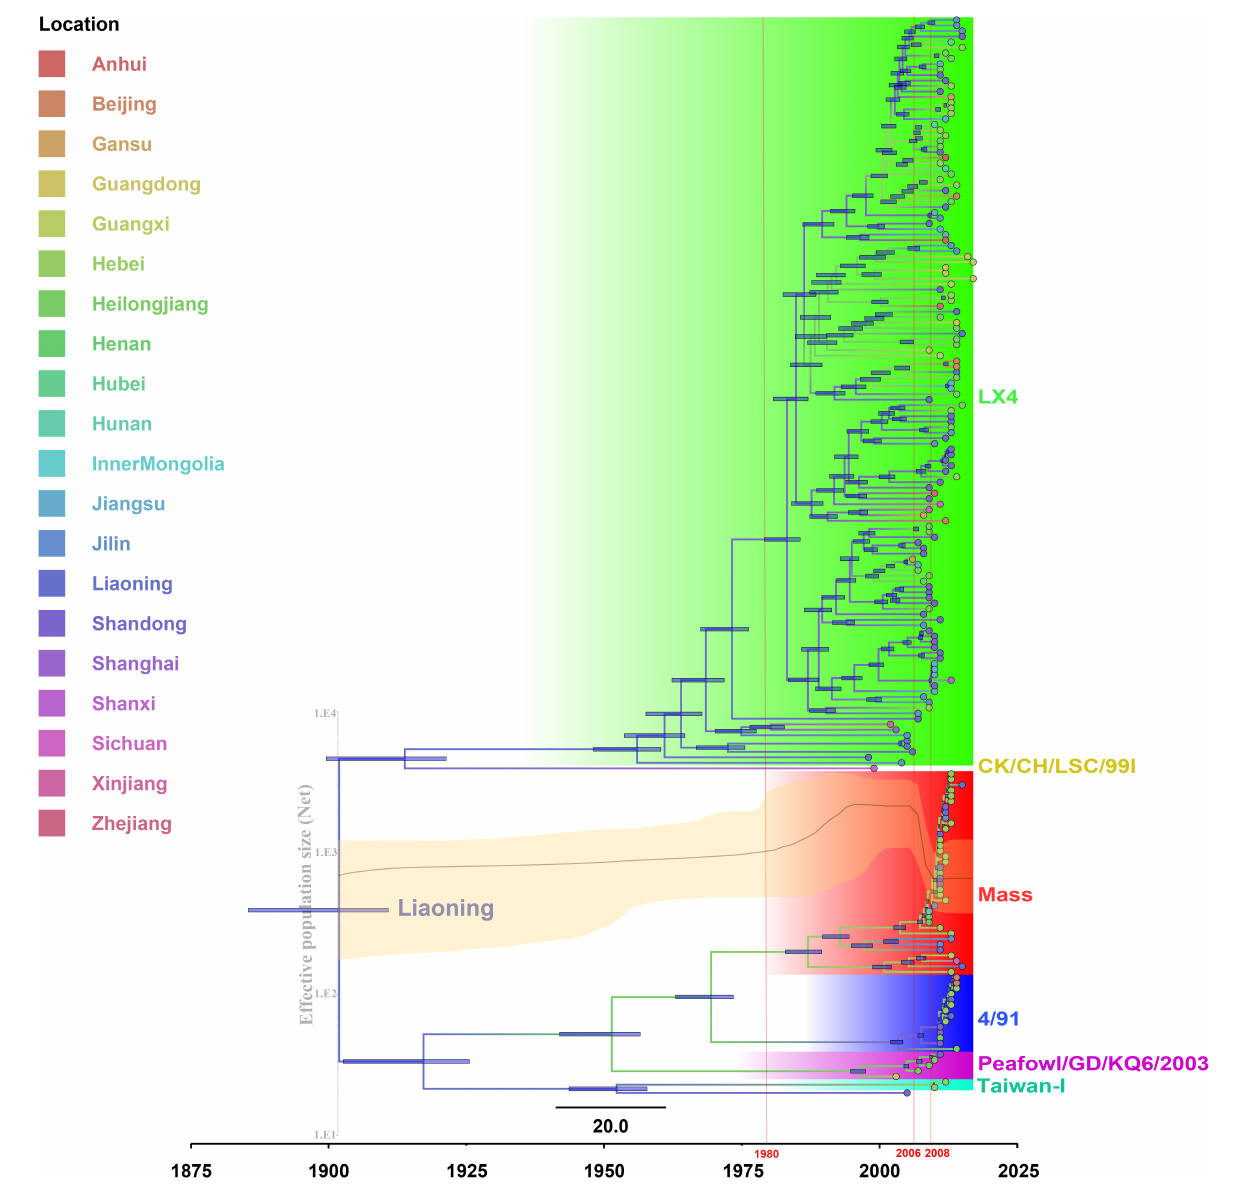
to have the highest dN/dS ratios compared with other